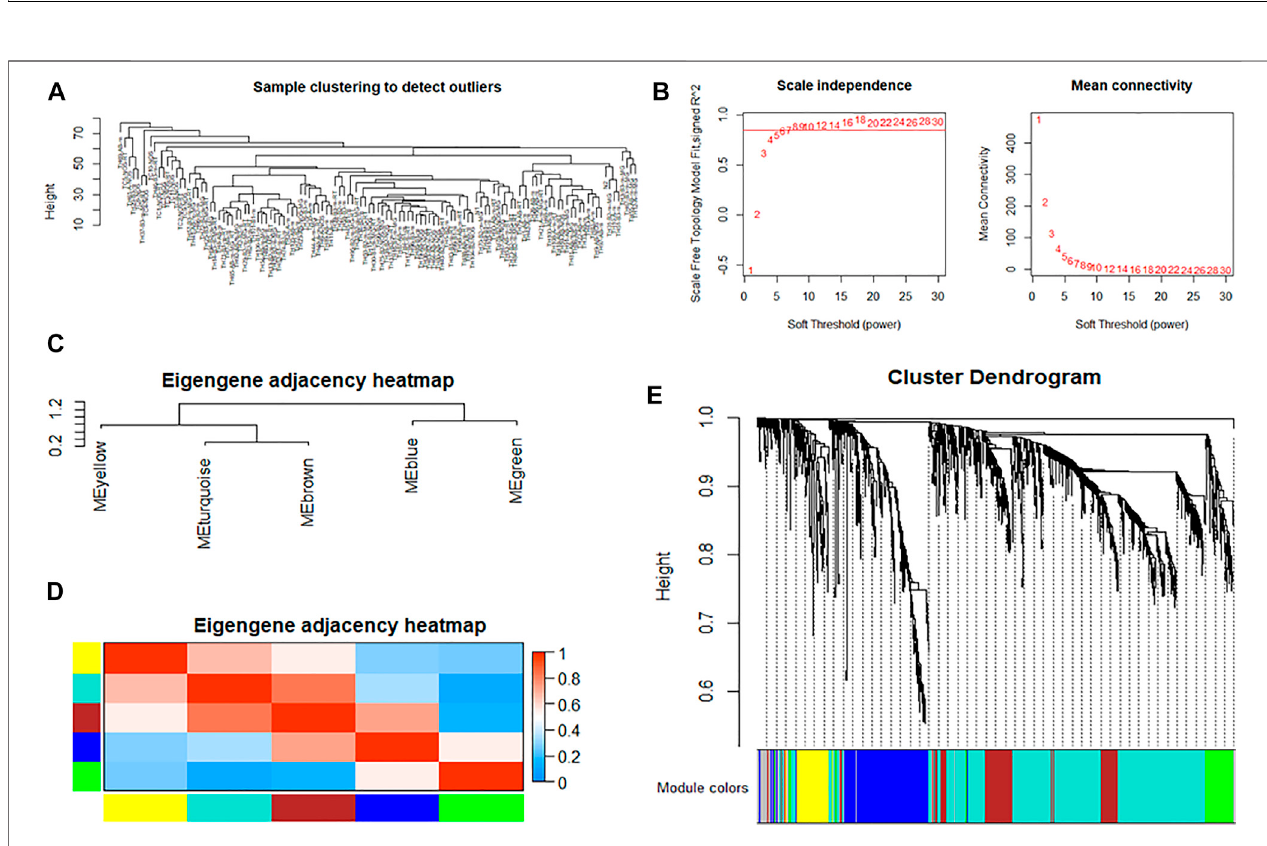
FIGURE 3 | WGCNA of immune genes in thymoma. (A) Cluster analysis of samples to detect outliers. (B) Determination of soft-thresholding power in weighted gene co-expression network analysis. The left shows the scale-free fi t index ( y -axis) as a function of the soft-thresholding power ( x -axis). The right shows the average connectivity (degree, y -axis) as a function of the soft-thresholding power ( x -axis). (C,D) Module eigengene dendrogram and heatmap of eigengene adjacency. (E) Clustering dendrogram of genes, with dissimilarity based on the topological overlap, together with assigned module colors.